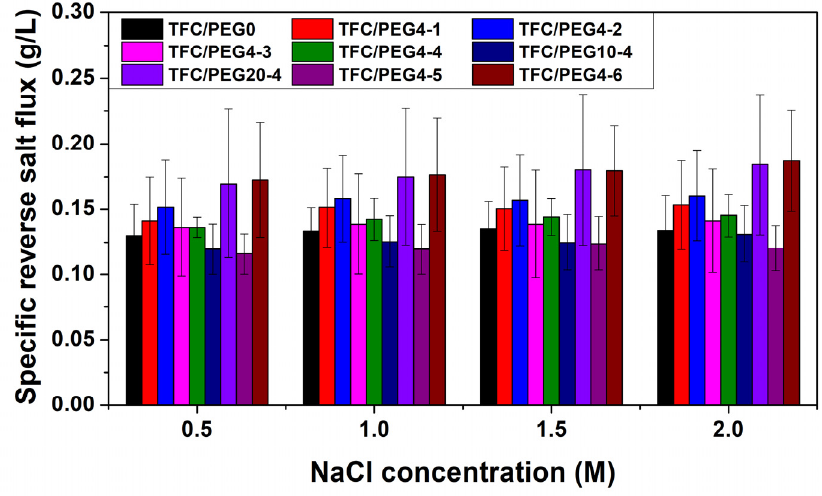
Figure 11. Specific reverse salt flux of PSU/PEG supported TFC-FO membranes.